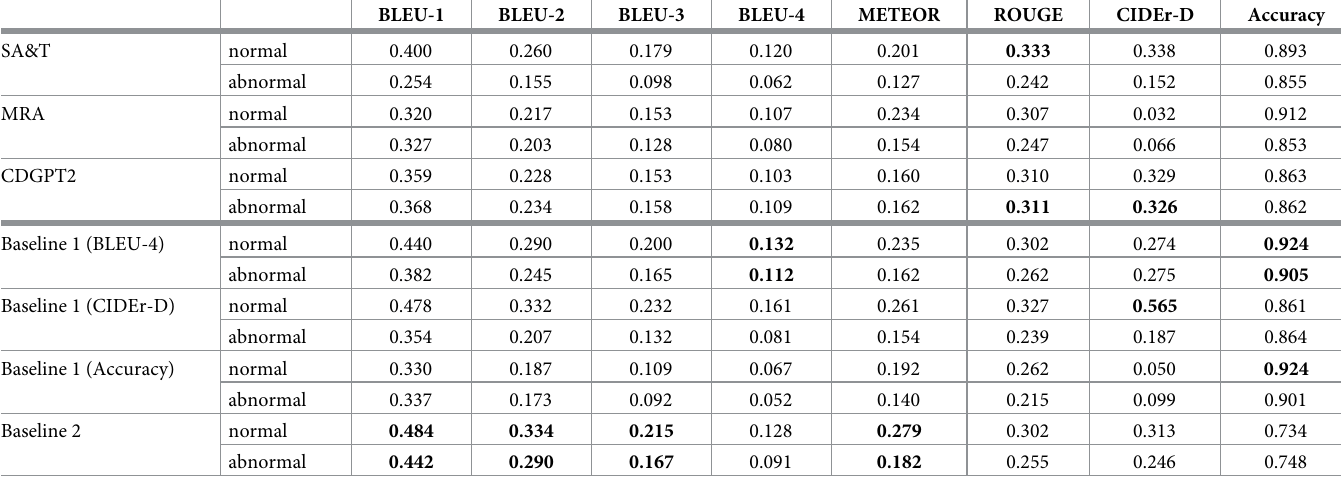
Table 4. Average validation scores for abnormal and normal reports on the IU chest X-ray dataset (Impressions and